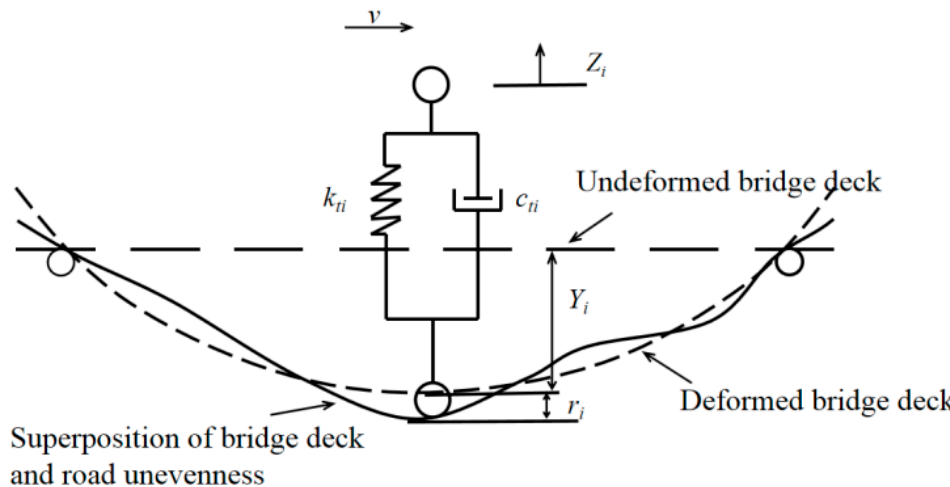
Figure 6. Mechanical model of wheel-bridge contact.